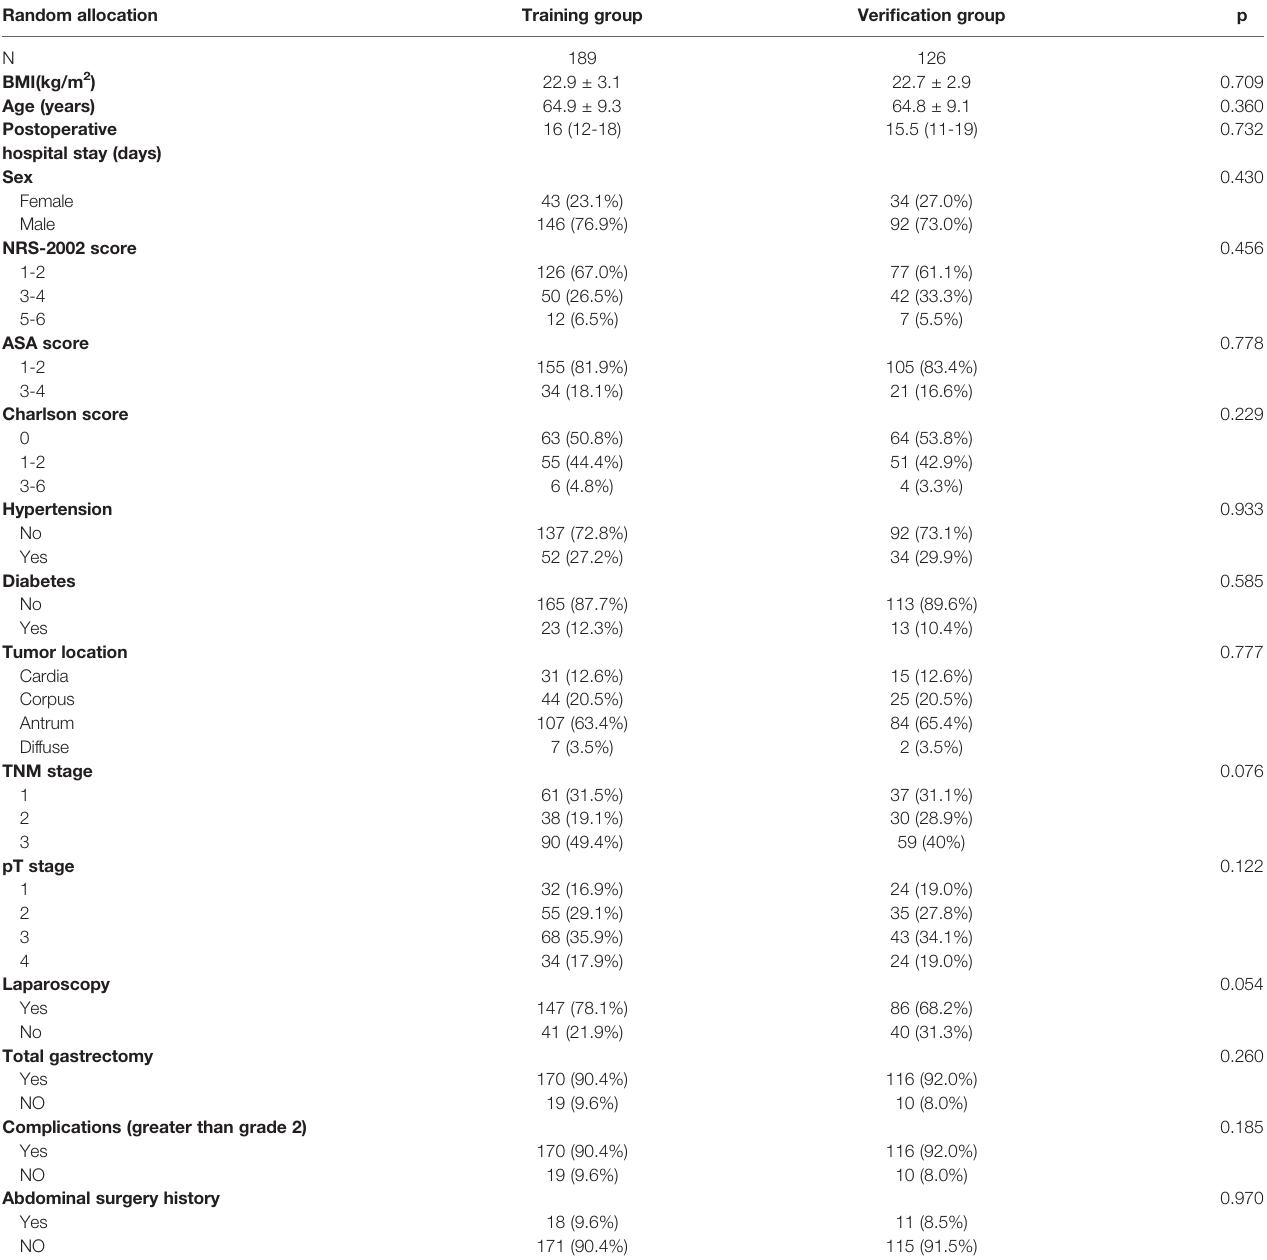
TABLE 1 | Clinical characteristics of